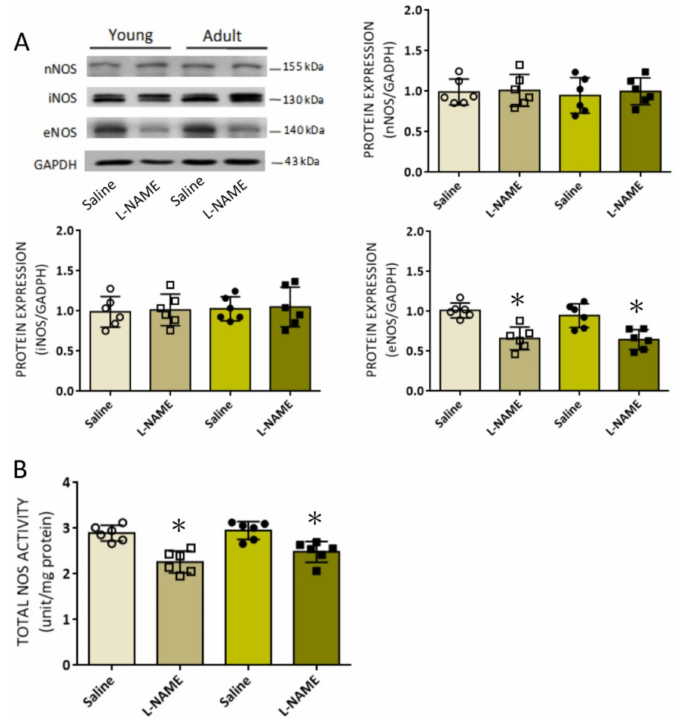
Figure 3. Effect of systemic L -NAME treatment on the expression of NOS isoforms and NOS activity in RVLM: ( A ) Representative gels (insets) and densitometric analysis of results from Western blot analysis showing changes in protein expression of nNOS, iNOS, and eNOS and ( B ) enzyme activity of NOS in RVLM 14 days after i.p. infusion of saline or L -NAME (10 mg/kg/day) in young (8 weeks, open circles or squares) or adult (20 weeks, filled circles or sqaures) rats. Data on protein expression were normalized to the respective saline control value, which is set to 1.0, and are presented as mean ± SD, n = 6 per group. * p < 0.05 versus corresponding saline-treated group in unpaired Student’s t